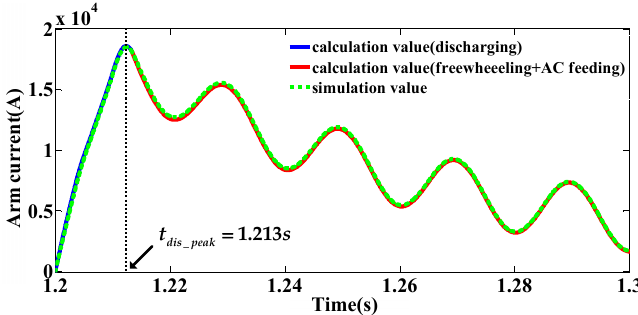
Figure 9. Simulation and calculation values of the arm current (Phase-A upper arm).